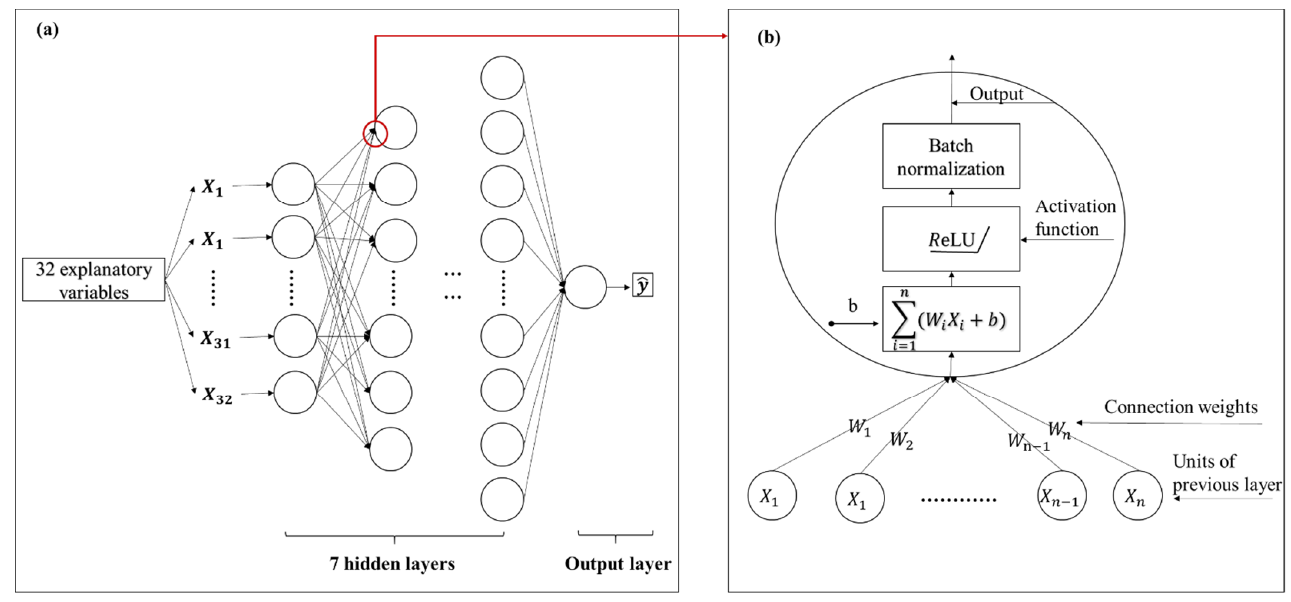
Figure 2. The structure of the DNN regression model ( a ) and the logic process of value derivation of each unit in the layer ( b ).